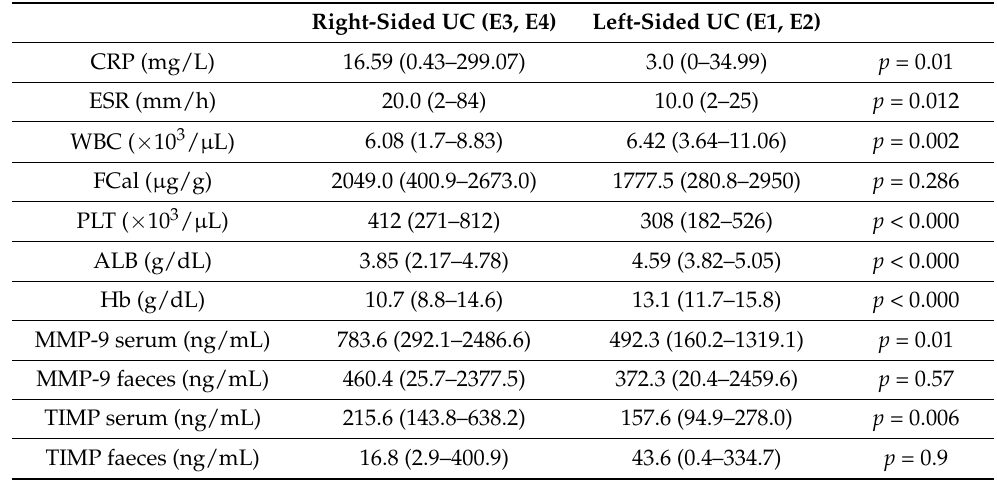
Table 4. Biochemical markers of inflammation and measurement of serum and faecal MMP-9 and TIMP-1 in children with right-sided and left-sided UC.